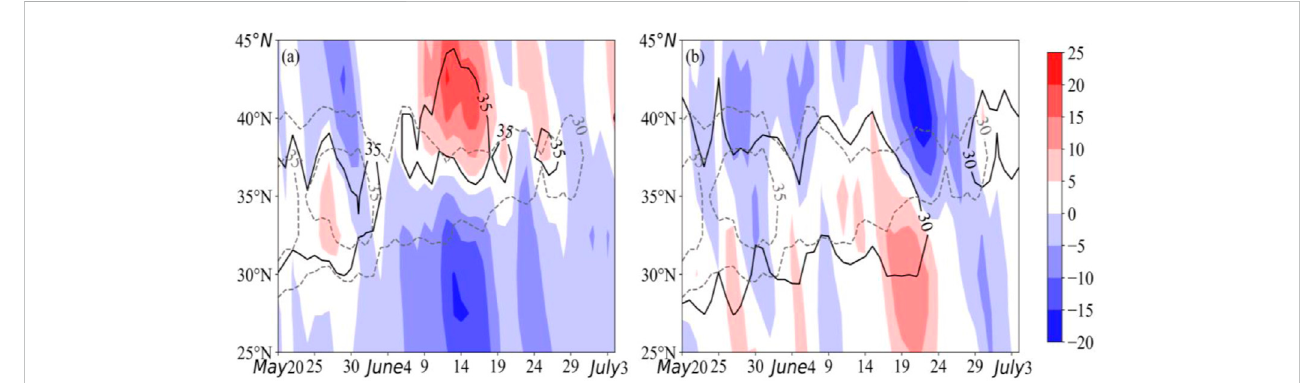
FIGURE 3 EastAsia110 ° -120 ° Eaverageof200 hPazonalwindanomaly(unit:m/s)time-latitudecrosssectionsinabnormalyearsofMeiyuonset (A) :earlyyears (B) : late years The shaded area is the anomaly, and the dashed (solid) line represents the 30 m/s, 35 m/s contour of the climatic average in abnormal years.